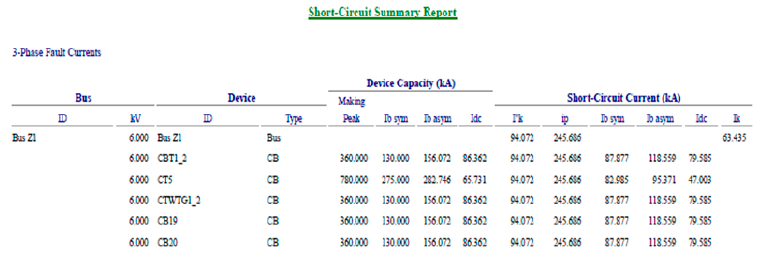
Figure 10. Three-phase fault current.